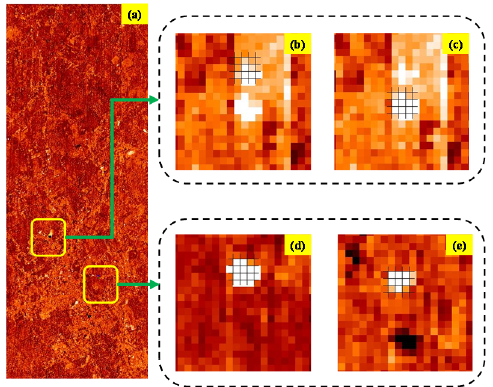
Figure 10. Target detection score image from ( a ) airborne imagery using THI target reference spectrum and the enlarged detection score footprint for ( b ) N3Y, ( c ) N4B, ( d ) N1G, and ( e ) N2Rtarget.